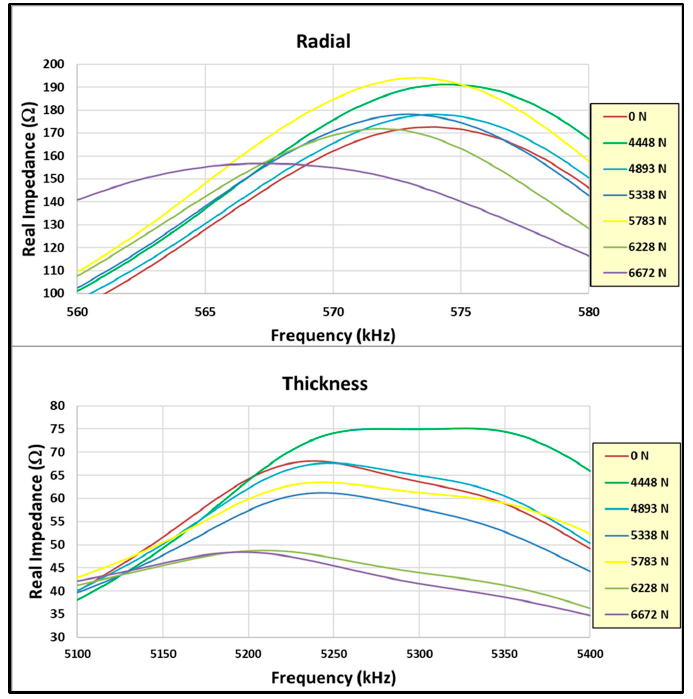
Figure 24. Radial and thickness impedance (real) resonance and load level for Sensor 11.